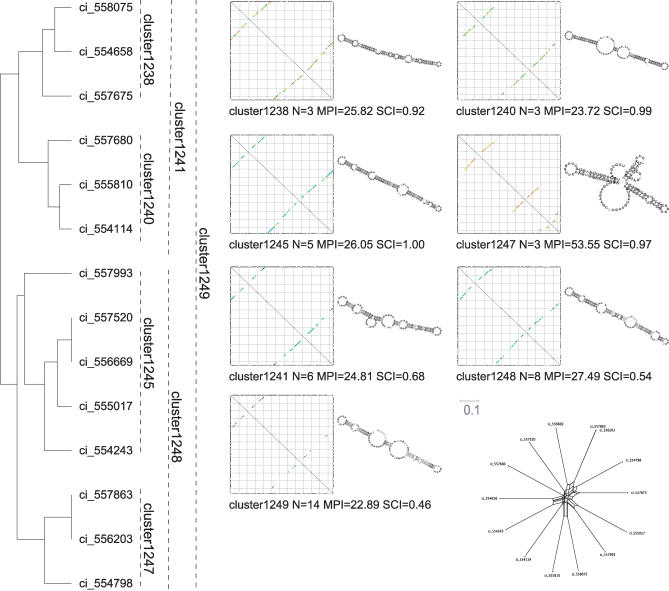
Example of Structure-Based Clustering of Very Diverse Sequences Which Might Form a Novel ncRNA ClassThe consensus structure models thus show a large number of compensatory mutations. N, number of sequences in cluster.